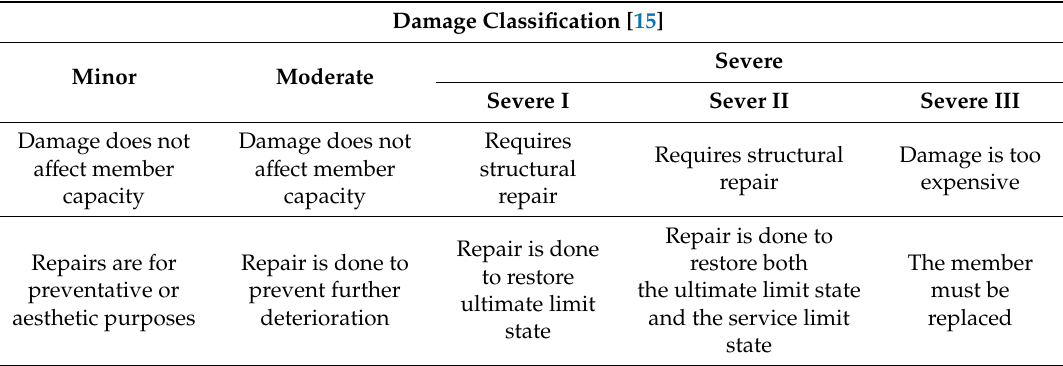
Table 1. Damage classification of bridge components and